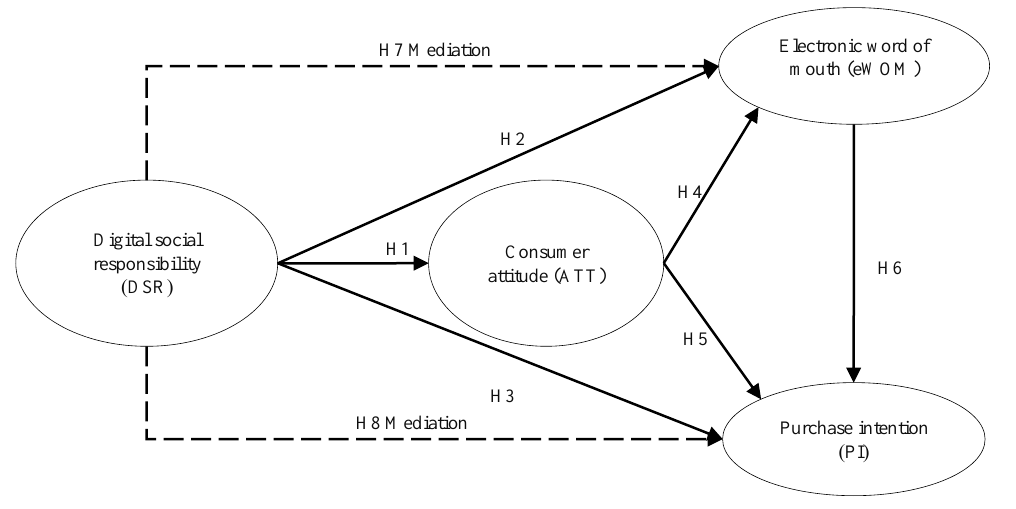
Figure 1. The proposed conceptual research